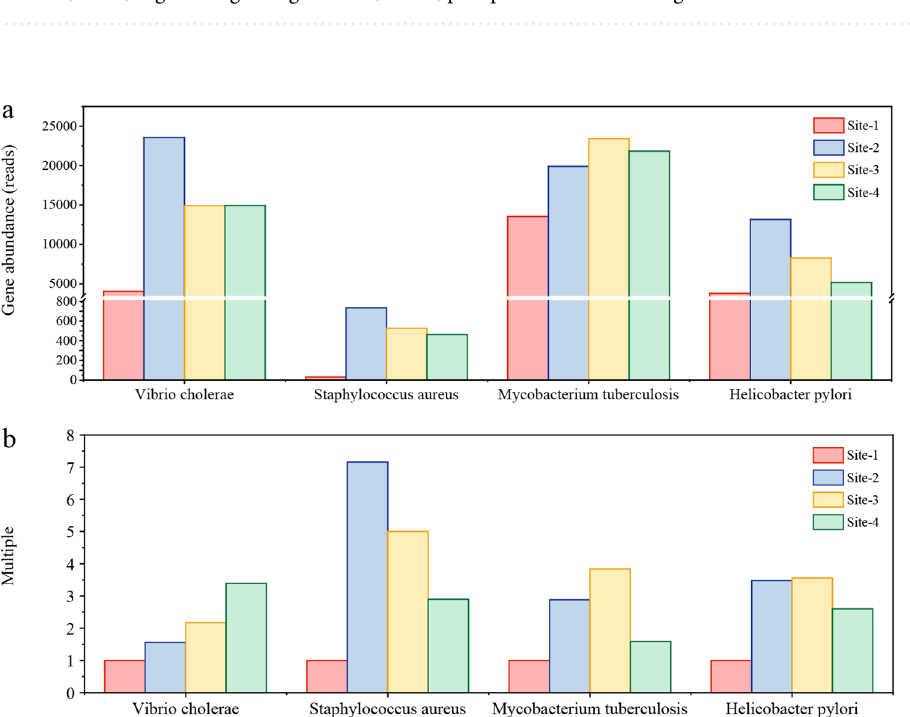
Figure 3. Prediction of abundance of genes related to infectious diseases ( a ) and the multiple relationship among them by qPCR ( b ) at four